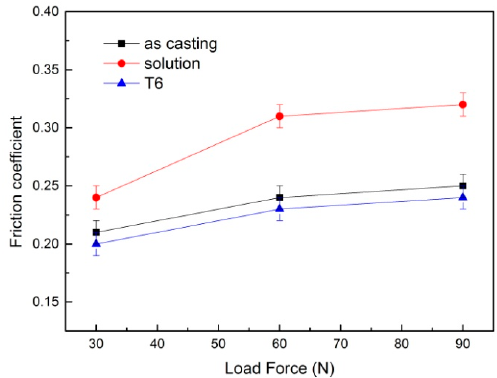
Figure 10. The friction coefficients of AZ91-1.0%Pr as-cast and after heat treatment.